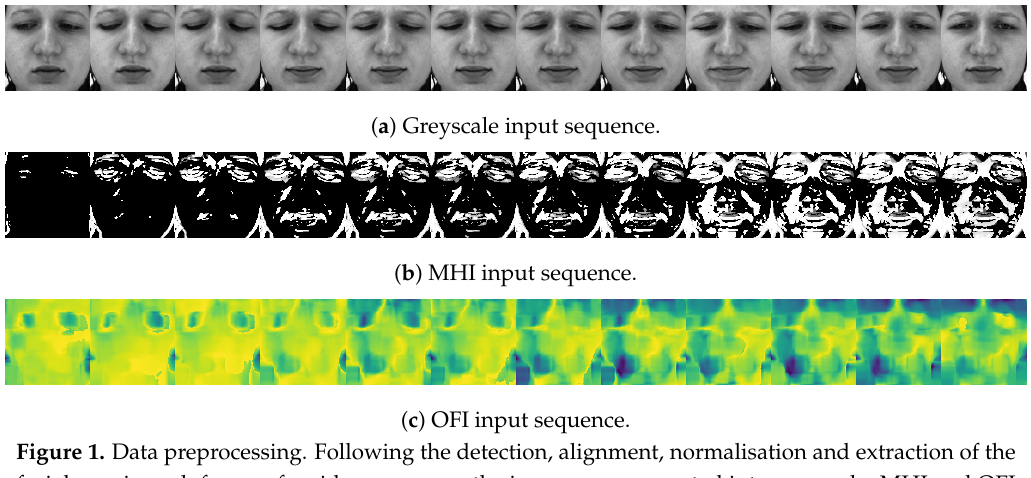
Figure 1. Data preprocessing. Following the detection, alignment, normalisation and extraction of the facial area in each frame of a video sequence, the images are converted into greyscale. MHI and OFI sequences are subsequently